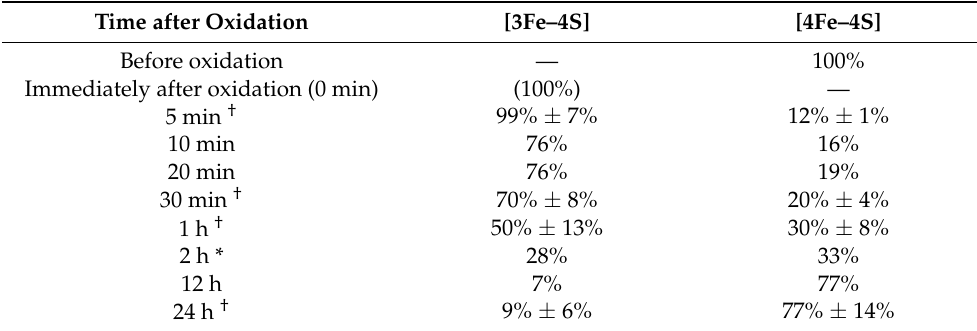
Table 1. Spectroscopic quantification of the Fe–S cluster bound to TtuA. Time after